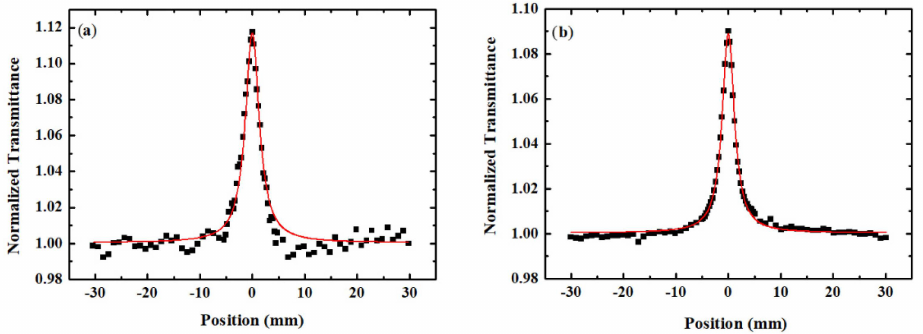
Figure 6. Representative open aperture Z-scan curves recorded for the ( a ) TF1 and ( b ) TF3